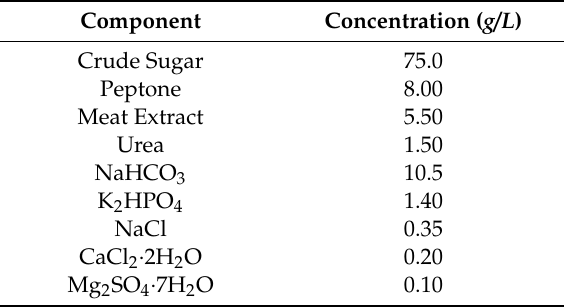
Table 1. Composition of the CSW used in this